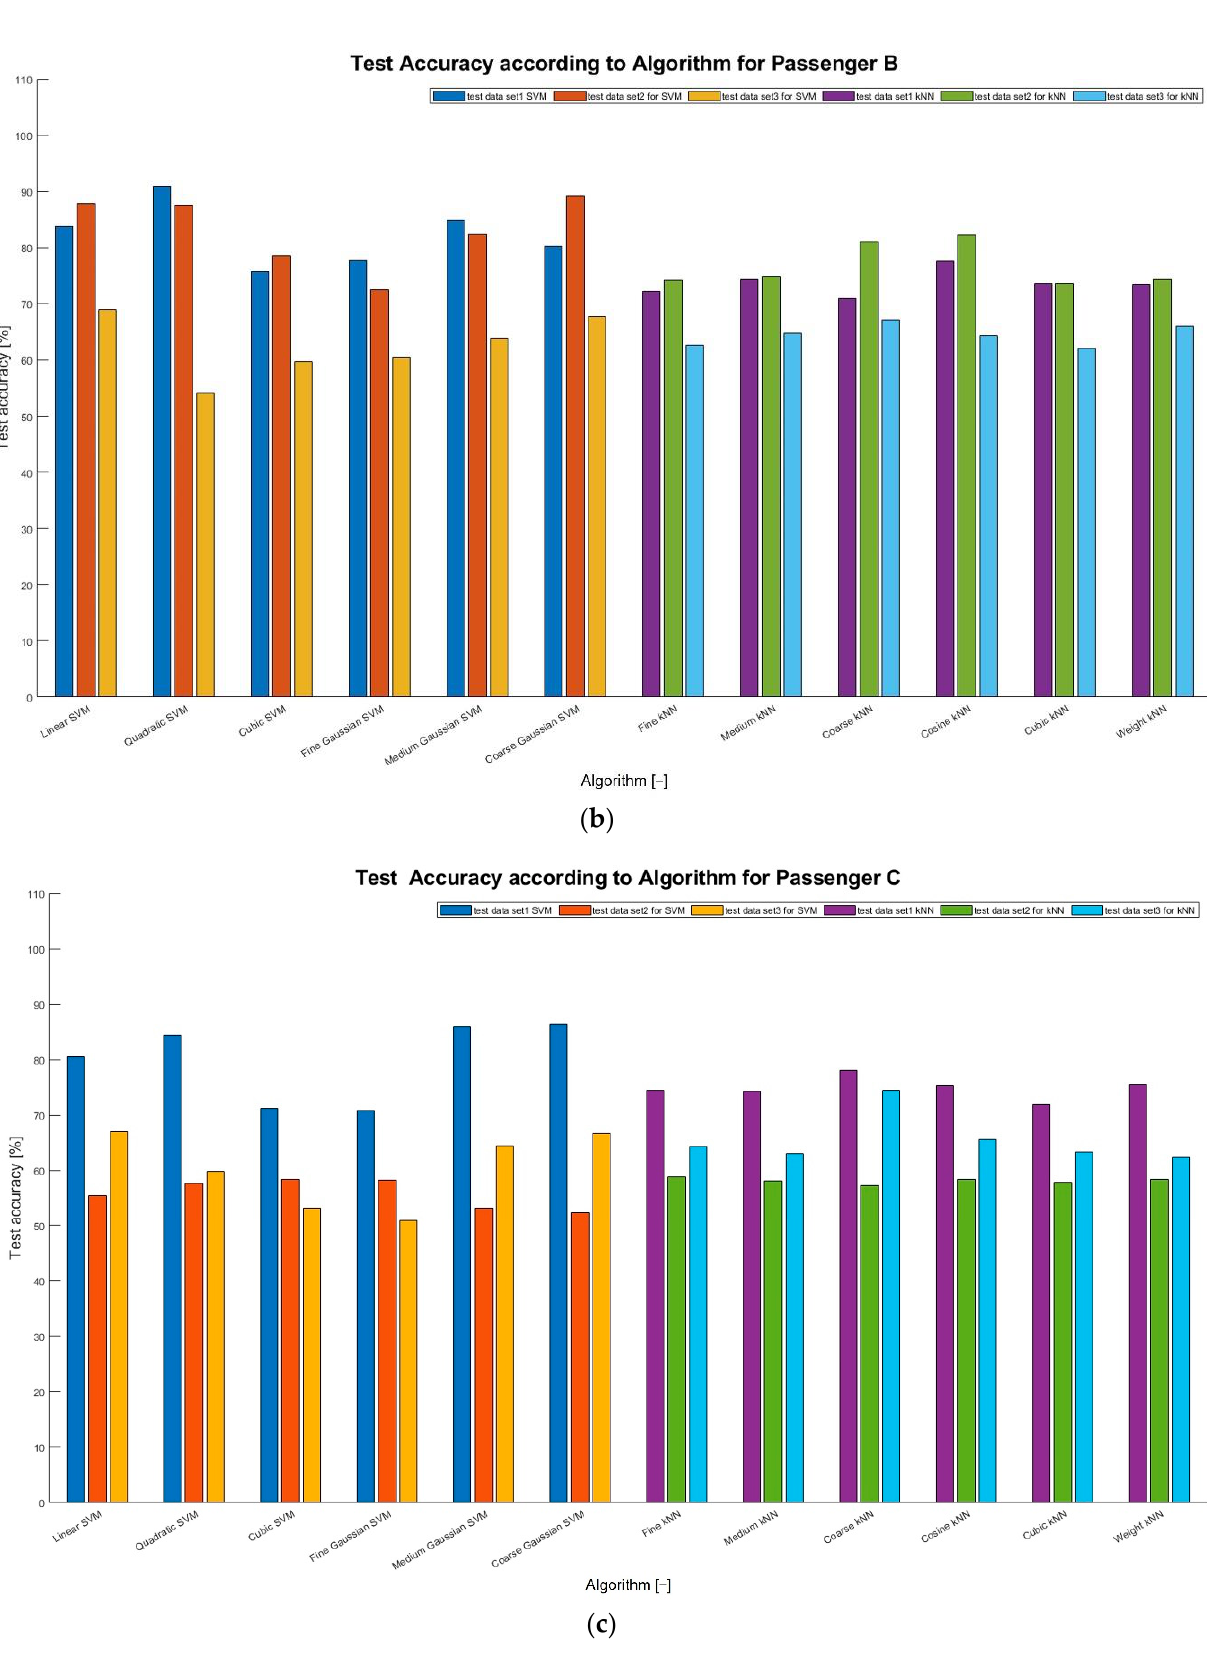
Figure 7. Test accuracy of all the passengers: ( a ) test accuracy of passenger A; ( b ) test accuracy of passenger B; and ( c ) test accuracy of passenger C.